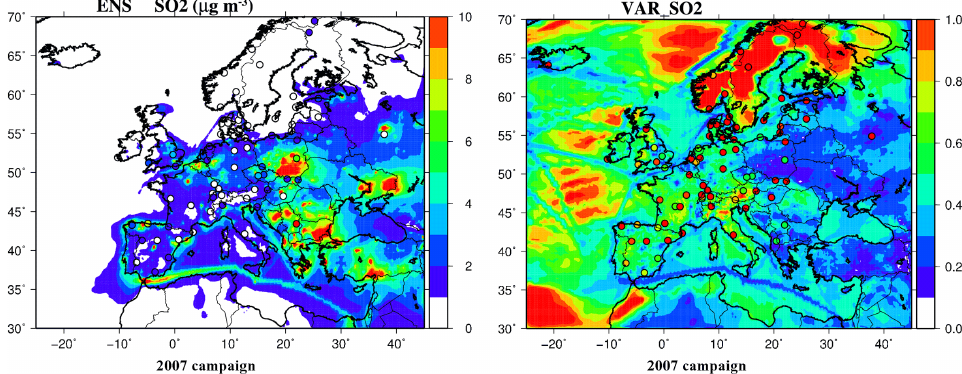
Figure 10. Left column: mean SO 2 concentrations (µgm − 3 ) of the ensemble (ENS) for the 2007 campaign with corresponding observations (coloured dots). Right column: coefficient of variation of models (no unit) constituting the ensemble with corresponding normalized root mean square errors of the ensemble (coloured dots). Red colour is assigned for values exceeding the colour